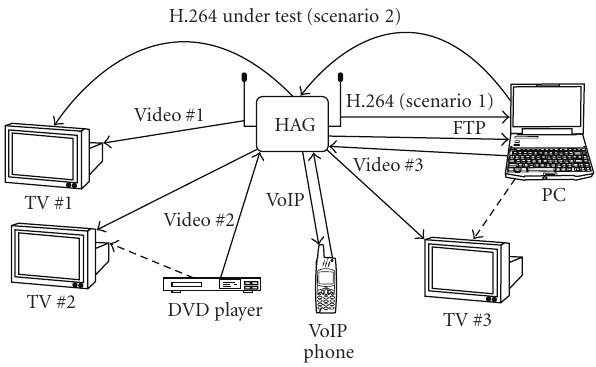
Figure 3: Home network scenario used in the experiments. The tested H.264 video stream is transmitted from the home access gate- way (HAG), that is, the access point, to the PC (scenario 1) or from the PC to the TV set (scenario 2). The solid lines show the actual path of the transmitted packets, while the dashed lines indicate log- ical